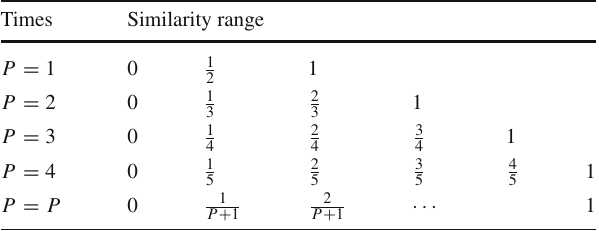
Table 1 Similarity range under different number of snapshots Times Similarity